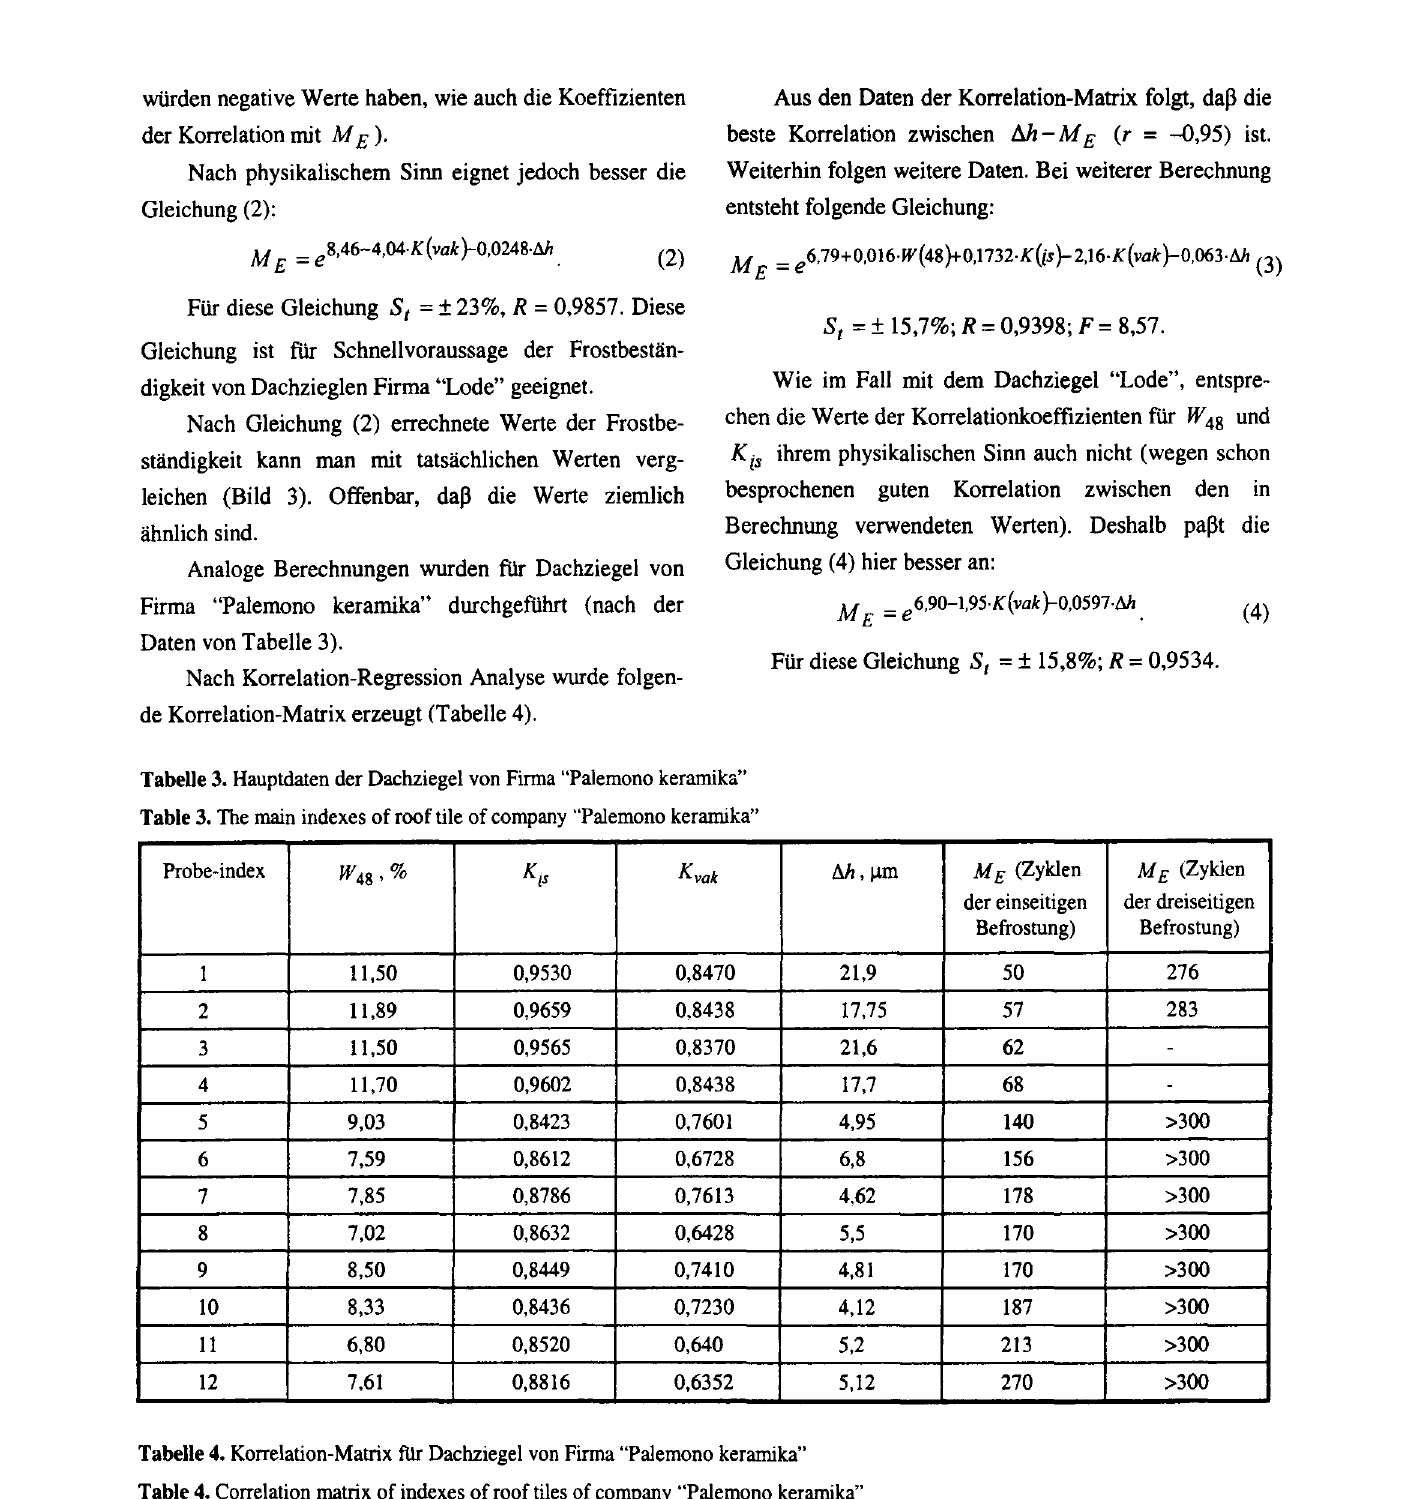
Table 4. Correlation matrix of indexes of roof tiles of company "Palemono kerarnika"